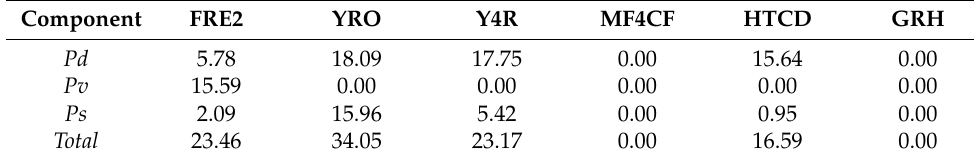
Table 4. The percentage of negative power pixels for each algorithm